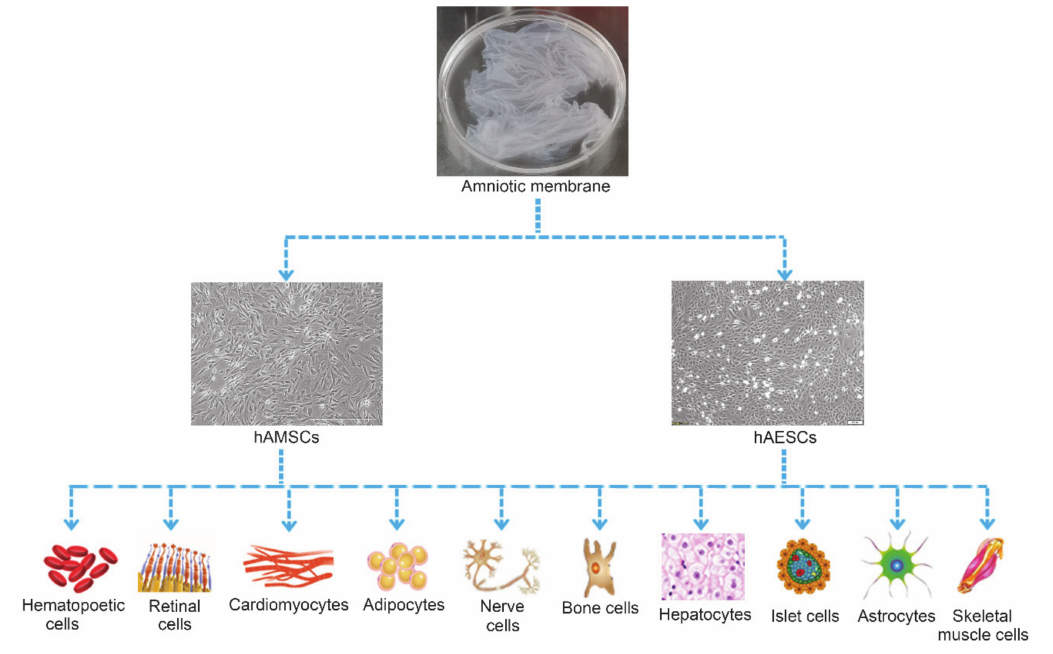
Figure 2. Multi-differentiation potential of hAMSCs and